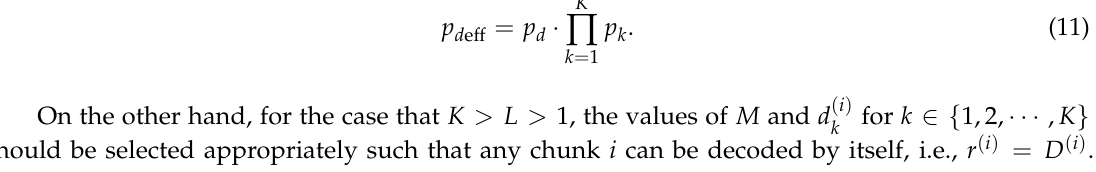
Figure 5. Example from point of view of the combined coding coefficient matrix. ( a ) γ ( i ) = 2, θ ( i ) = 2; ( b ) γ ( i ) 1, θ 2 1 The decodability of chunk i is given with different possibilities of recovered